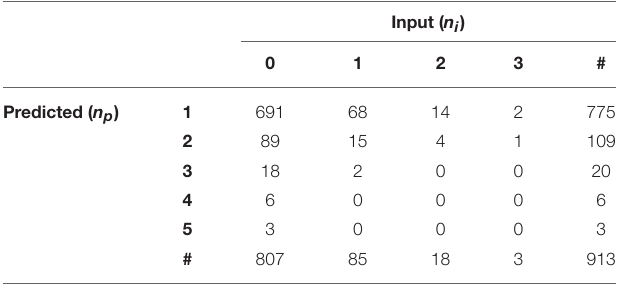
TABLE 3 | Co-occurrence of genes in network proximity to ASD risk genes from one or more